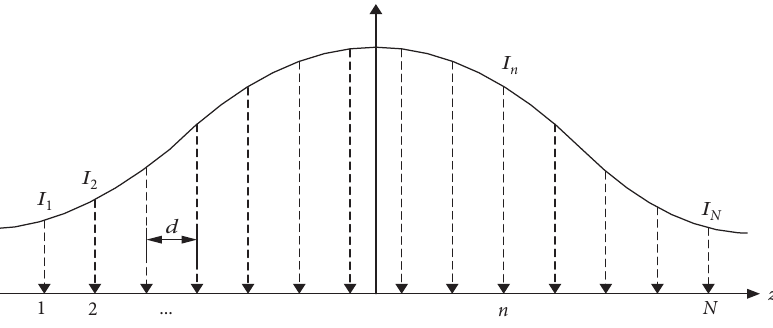
Figure 6: Discrete sampling of continuous Taylor